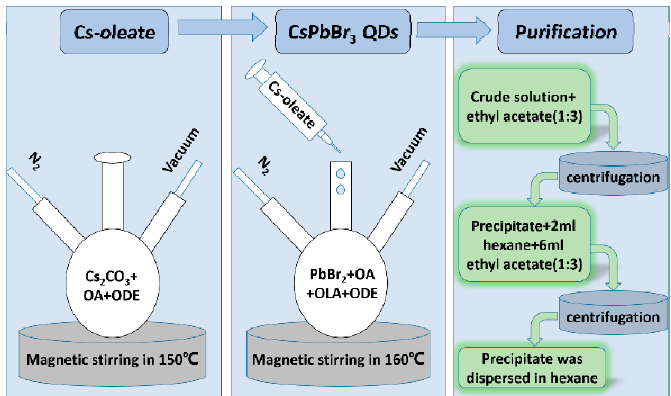
Figure 1. Preparation steps of CsPbBr 3 QDs.